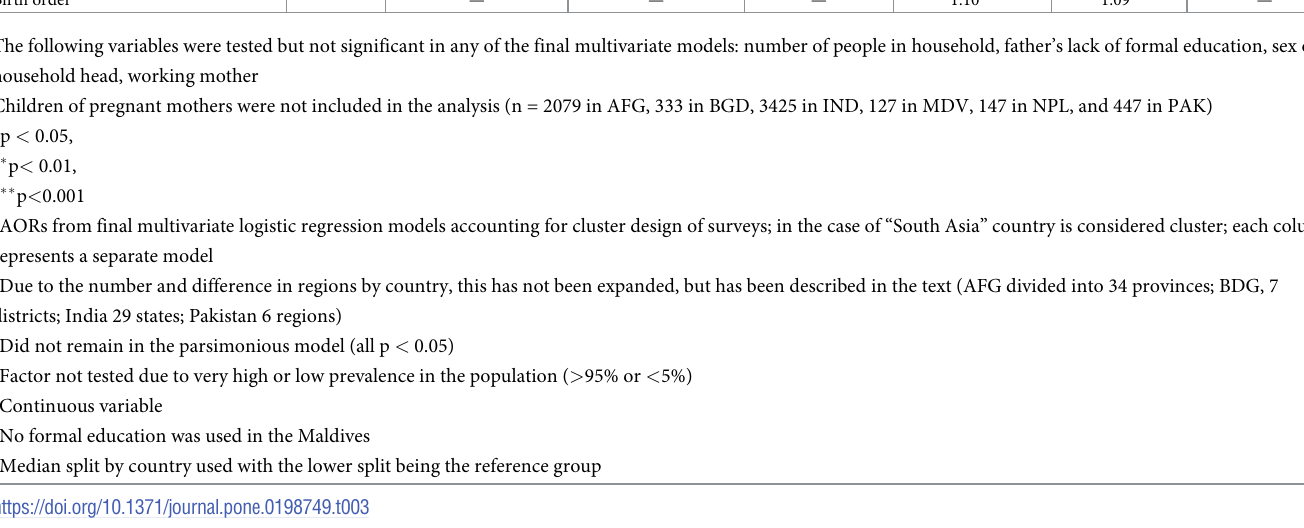
1.10 (cid:3)(cid:3) 1.09 (cid:3)